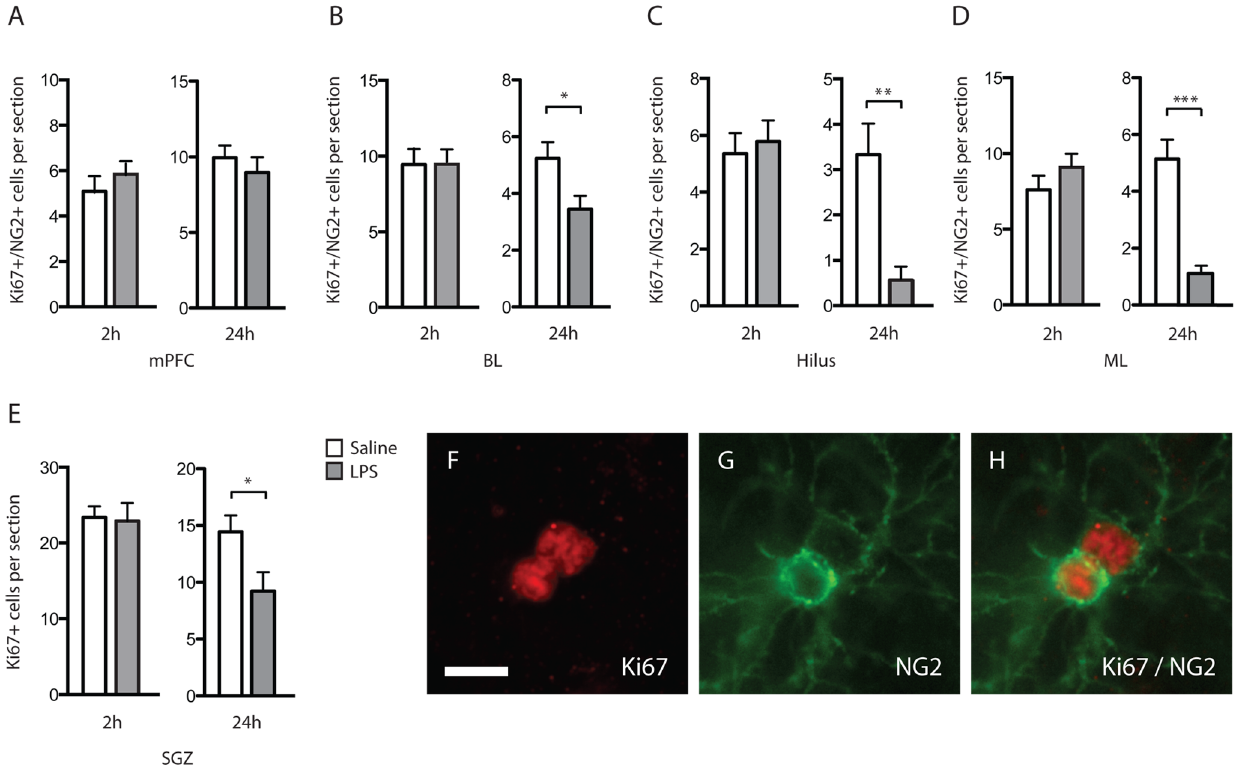
Figure 2. Proliferation of NG2 + cells in response to systemic lipopolysaccharide treatment. Unaltered number of NG2 + /ki67 + cell numbers was found in the medial prefrontal cortex (mPFC) (A), the basolateral nucleus (BL) (B), the dentate hilus (Hilus) (C) and the molecular layer (ML) (D) 2 h after lipopolysaccharides (LPS) treatment compared to saline treatment (Saline). In contrast, a significant decreased number of NG2 + / ki67 + cells were detected in the BL (B), the Hilus (C) and the ML (D), but not in the mPFC (A), 24 h after LPS treatment compared to saline treatment. The number of Ki67 + cell in the subgranular zone (SGZ) of the hippocampal granular cell layer (E) was also unaltered after 2 h, but significantly reduced 24 h after LPS compared to saline treatment. *** indicates a significant difference at p , 0.001 level. ** indicates a significant difference at p , 0.01 level. * indicates a significant difference at p , 0.05 level. Images in (F–H) demonstrate a double immunoflourescence staining with antibodies directed against the endogenous proliferation marker Ki67 (F) and NG2 (G). Images (F) and (G) are superimposed in (H). Scale bar=10 m m.